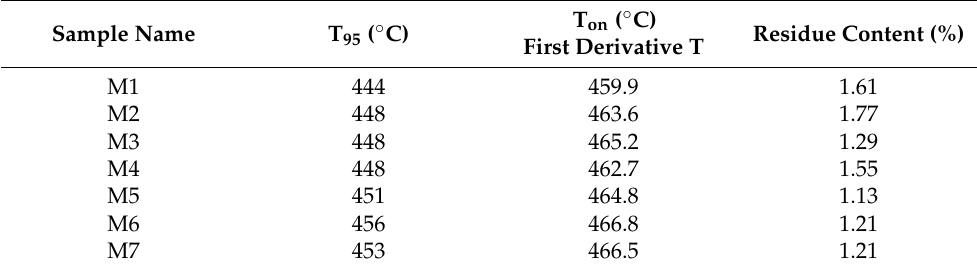
Table 2. Summary of the TGA results of the prepared HDPE/CNTs nanocomposite sheets under air atmosphere, at a heating rate of 10 °C /min.